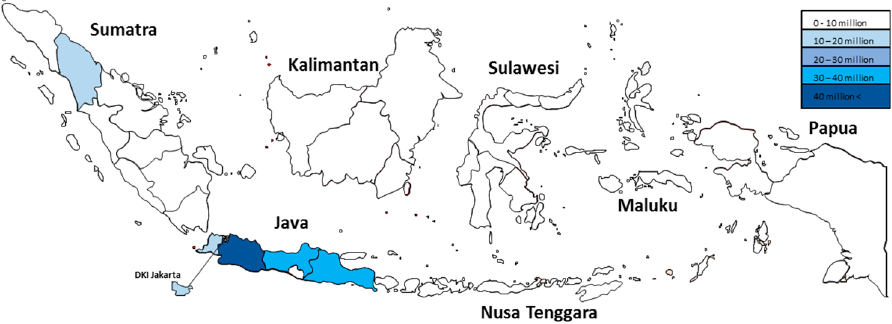
Figure 2. Spatial population profiles among regions in Indonesia.